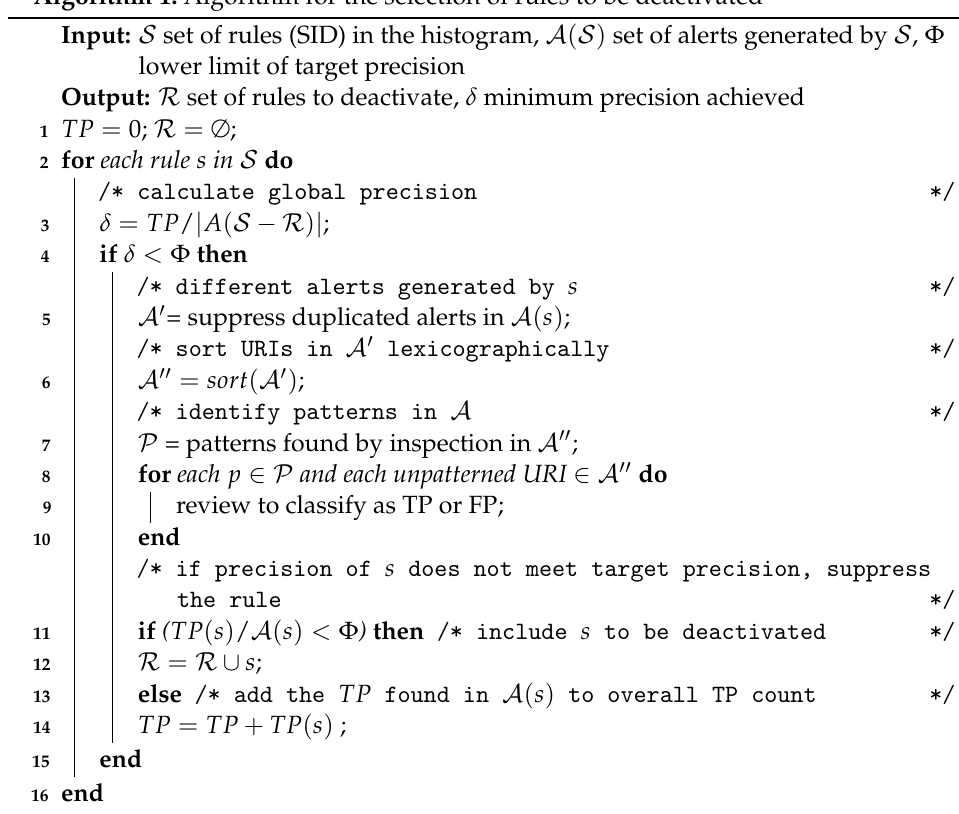
Algorithm 1: Algorithm for the selection of rules to be